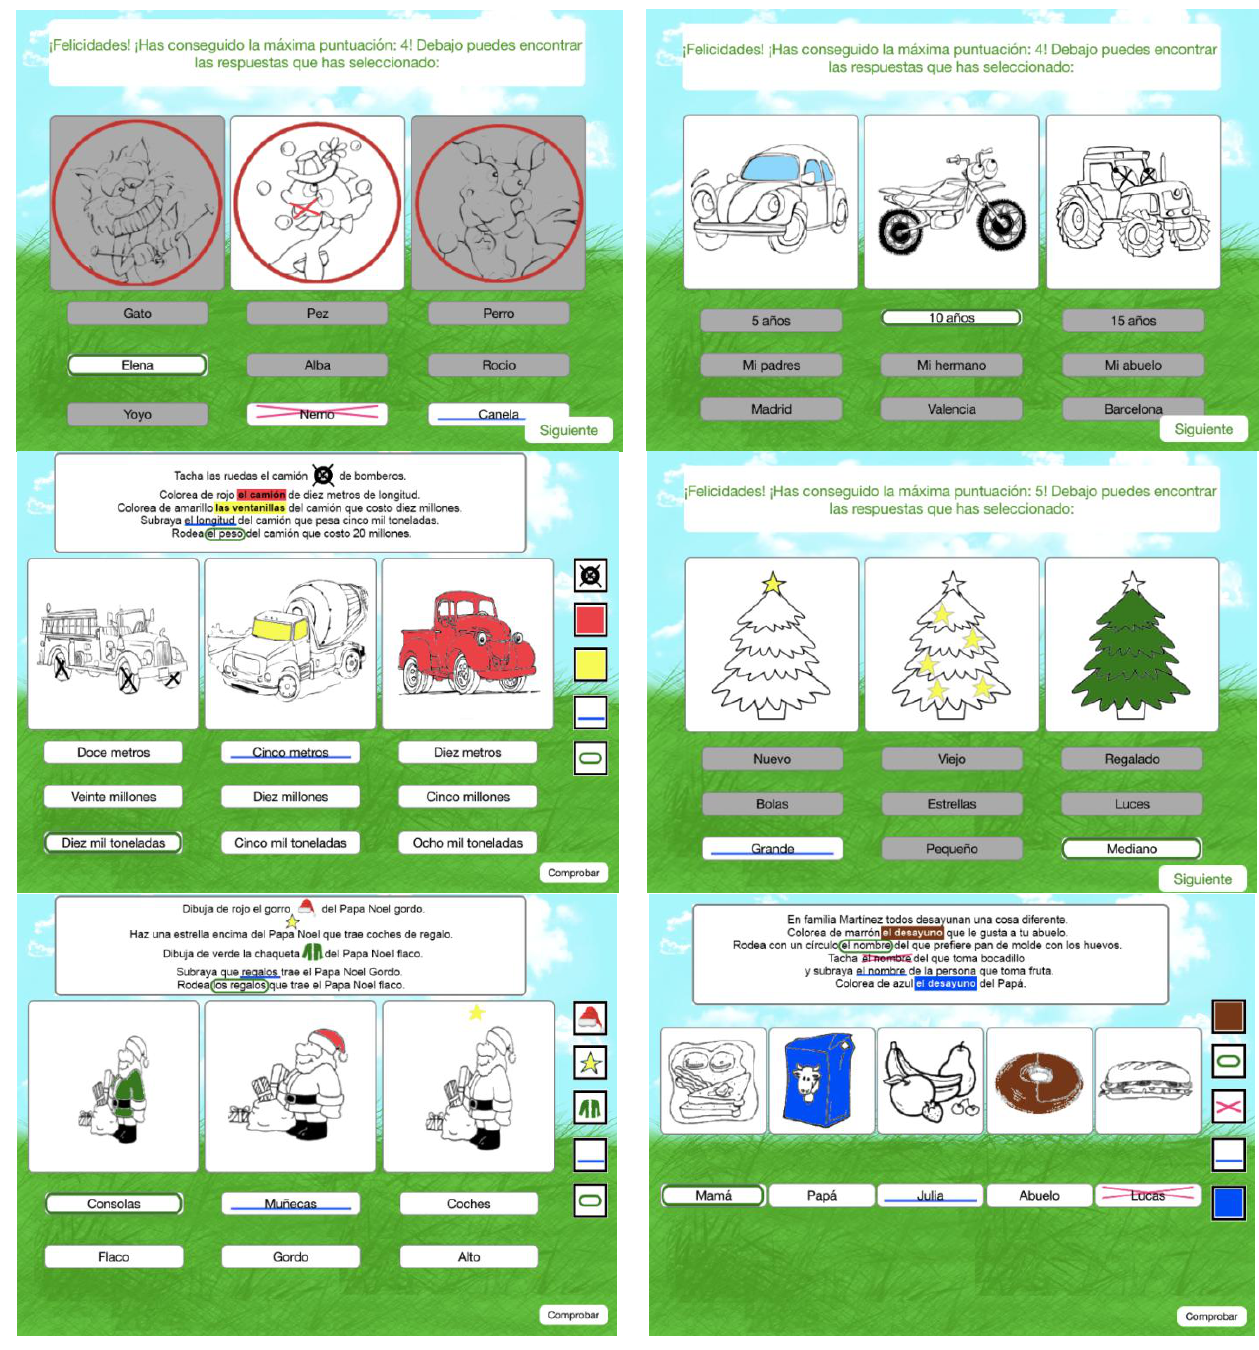
Figure 2. Screenshots of the